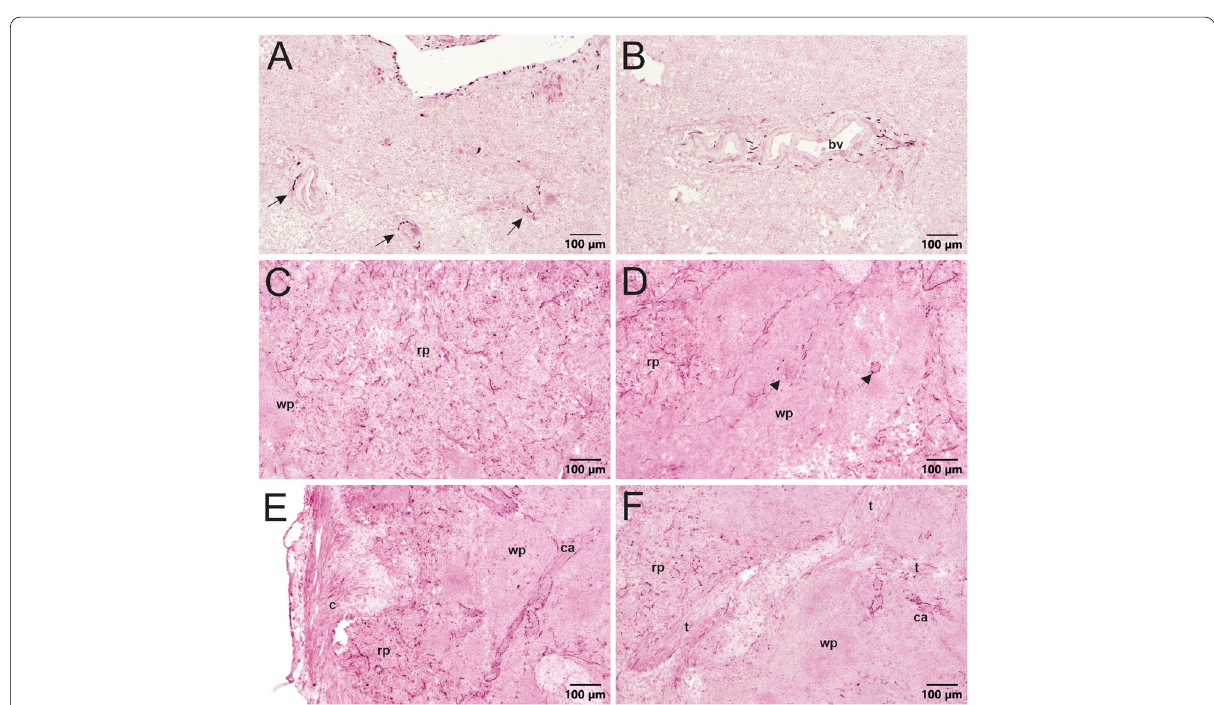
Fig. 7 A comparison of NPY staining in sections of human ( A - B ) and porcine ( C - F ) spleen. NPY sympathetic nerves are associated with + splenic vasculature, like TH, in human spleen. A NPY nerve staining around central arterioles (arrows) in section from donor 002 spleen. Few + nerves extend a short distance into the surrounding parenchyma. B NPY nerves around a central arteriole in section from donor 004 spleen. + C Robust staining for NPY nerves throughout the red pulp (rp) of pig spleen. White pulp (wp) has considerably less NPY staining. D Sympathetic + nerves stain for NPY near and extending from central arterioles, indicated by arrows, within the white pulp. E The capsule does not contain NPY innervation, but the red pulp beneath the capsule and the central arteries (ca.) extending from the capsule are heavily innervated. + F Sympathetic nerves run parallel to trabeculae (t) in pig spleen